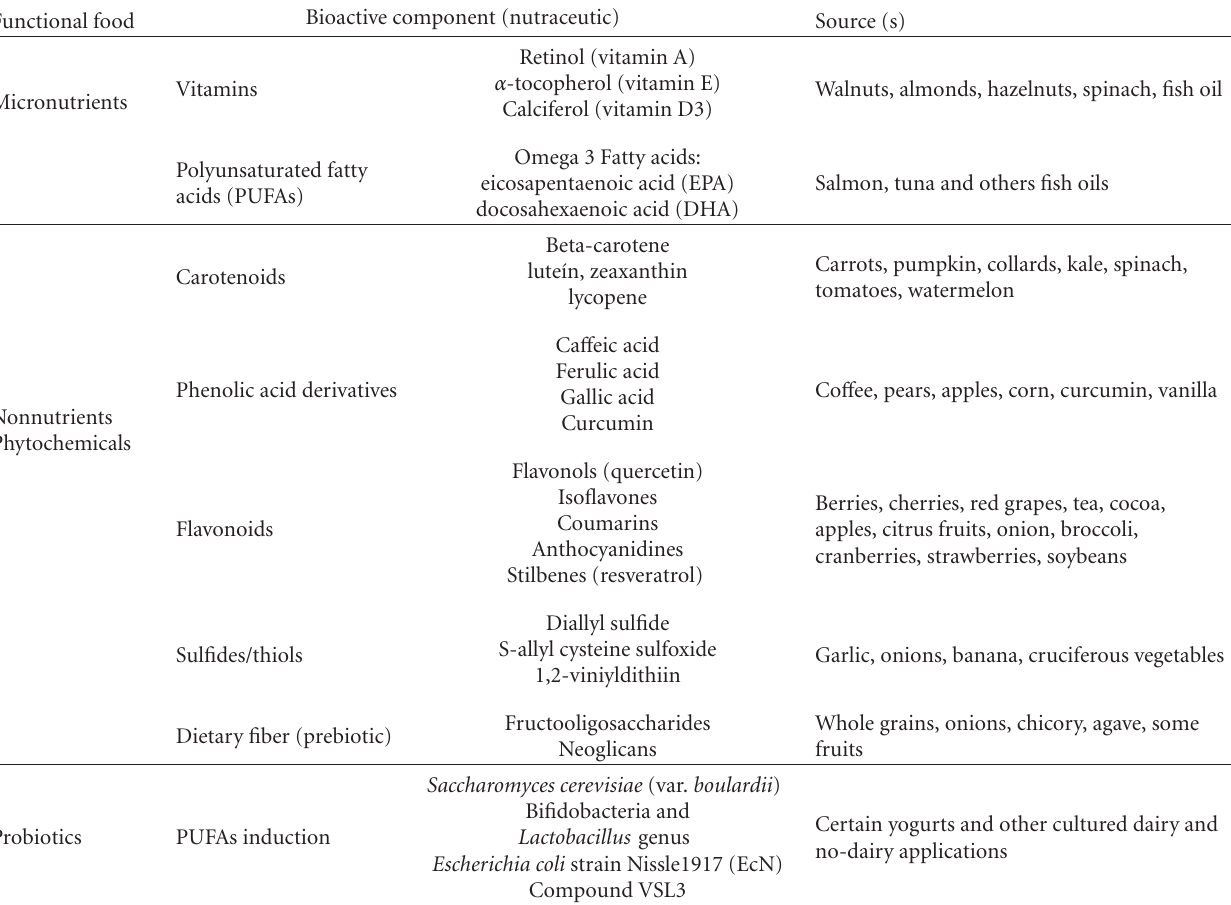
Table 1: Functional foods classification, some sources, and examples of bioactive substances. Functional food